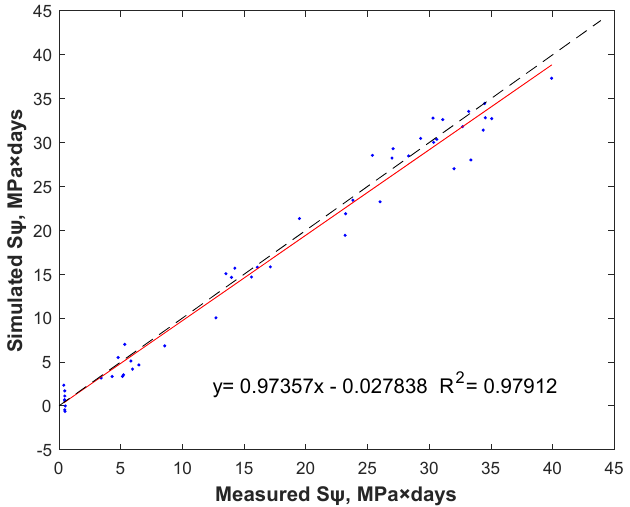
Figure 6. Correlation between the measured and predicted S ψ using the best predictive RGB ANN model in the 2018 season. Table 5. Validation results (R 2 : determination coefficient, RMSE: root mean squared error, and RE: relative error) for the ANN regression models and MRM using multispectral bands and GCC MULTI to simulate the S ψ for every studied season in a vineyard cv. Monastrell, located in south-eastern Spain. Statistical values shown in bold indicate the best-performing